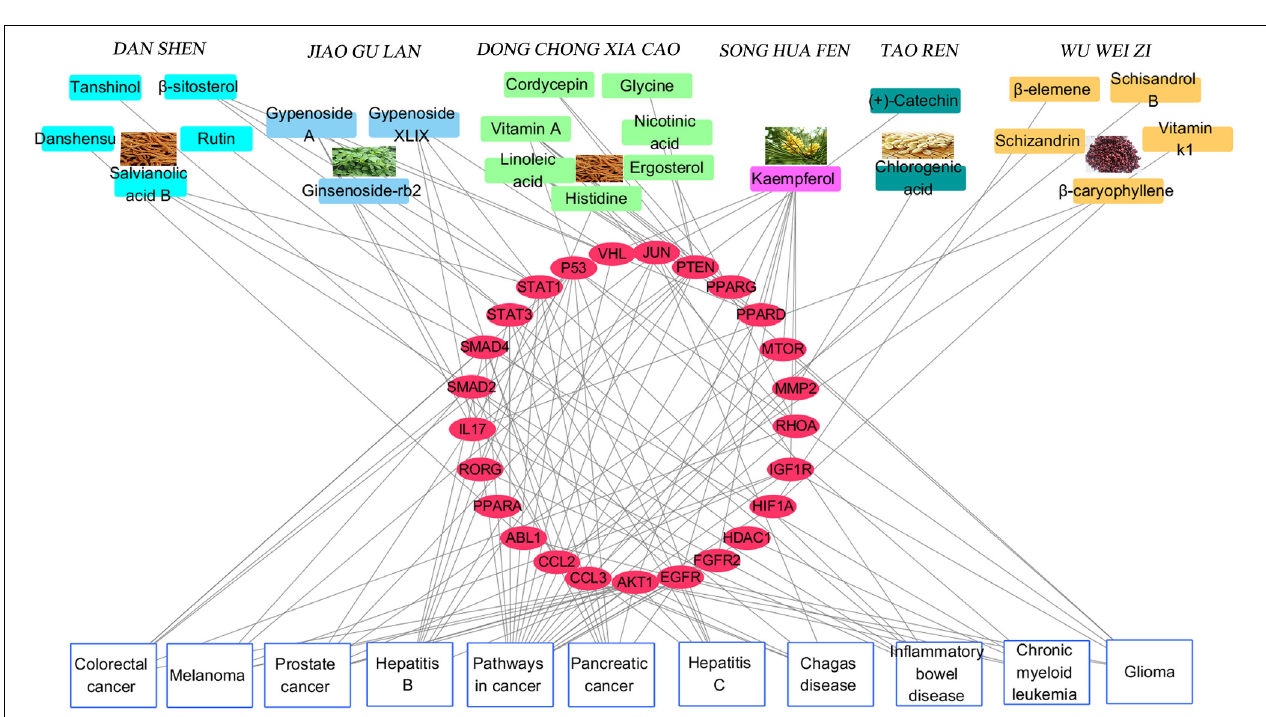
FIGURE 4 | Component-Target protein-Disease network. The Top rectangles in the network represent active components of six herbs in FZHY, red ellipse nodes in the Middle of the network denote target proteins of active compounds, the Bottom rectangles refer to diseases correlated with above target proteins.